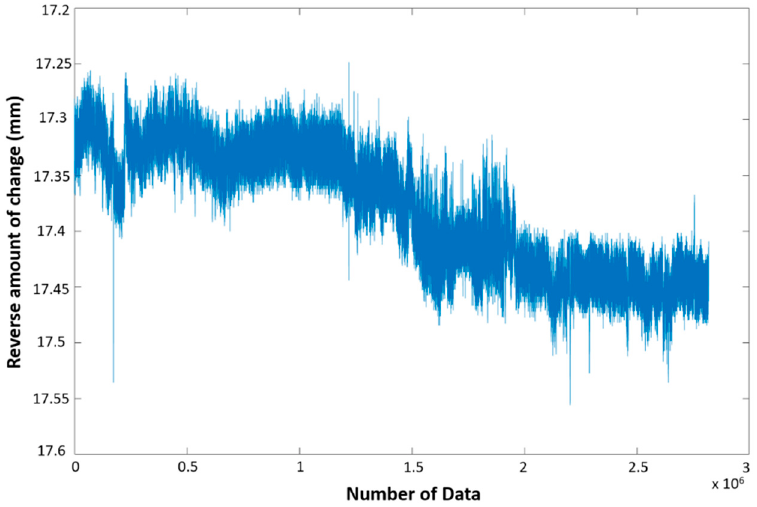
Figure 12. LR score (CV) for the RUL of the WHRA obtained by the LR model.